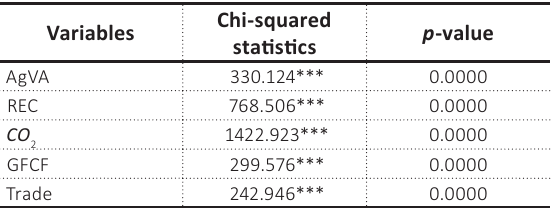
Table 3. Breusch-Pagan test of independence